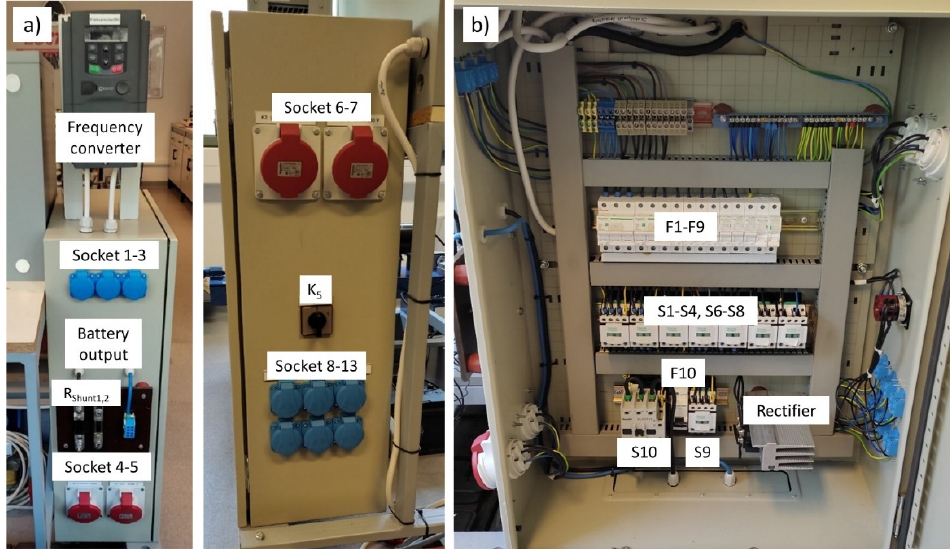
Figure 7. The electrical switch cabinet and control desk.